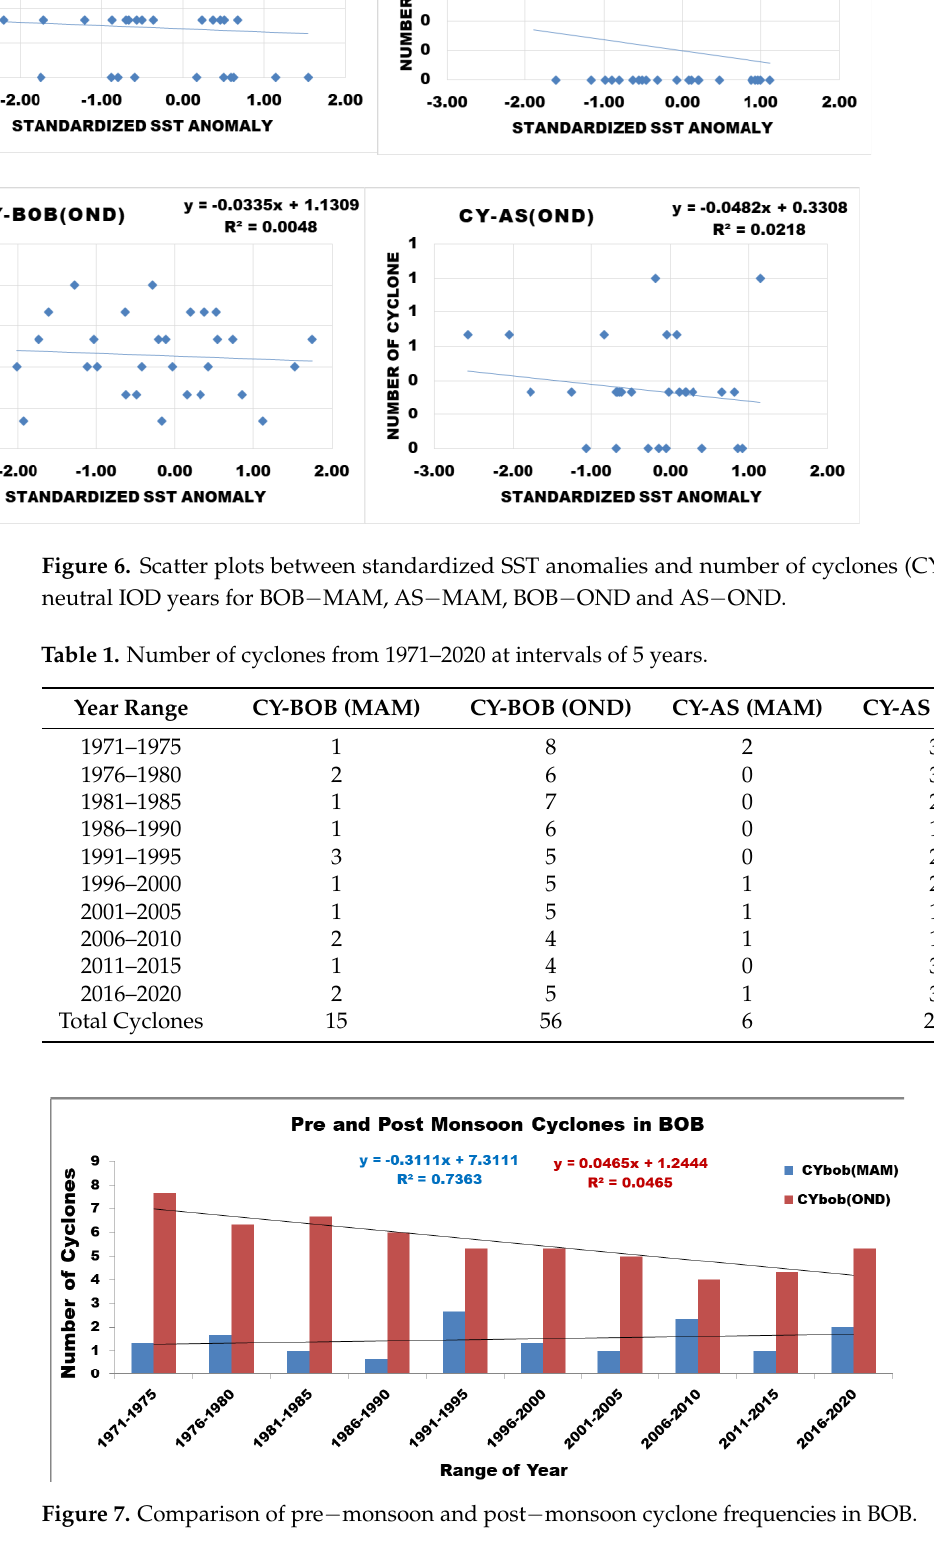
Figure 8. Comparison of pre −monsoon and post − monsoon cyclone frequencies in AS. Further analysis of the pre −monsoon and post − monsoon cyclones for the BOB and AS, IOD − year − wise (negative, neutral, positive), reveals that the maximum cyclones oc- curred during neutral years followed by positive IOD years in the post − monsoon season (Table 2 and Figure 9). Table 2. Number of cyclones from 1971 to 2020 for negative, neutral and positive IOD years. IOD Years (50)